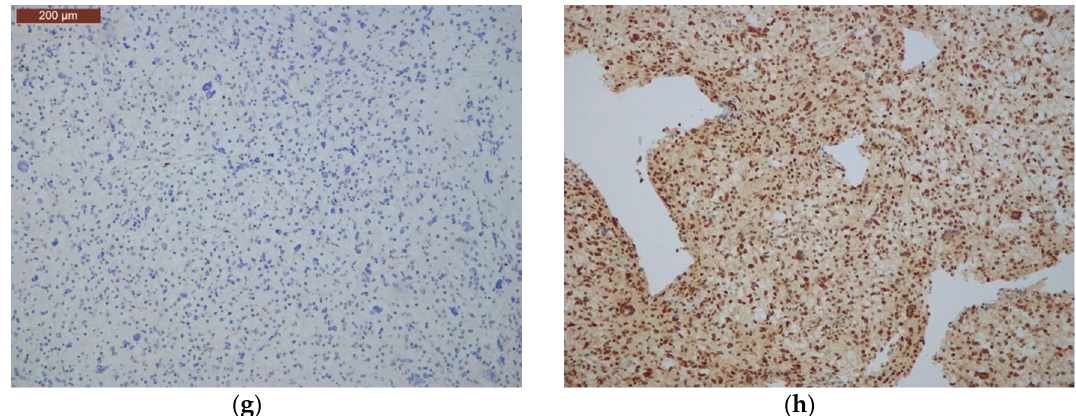
Figure 5. Immunohistochemical analysis of mutated mismatch repair genes in cases 5 GL ( a – d ) and 12 GL ( e – h ). Case 5 GL shows loss of MSH2 expression ( b ) and positive staining for MLH1, MSH6 and PMS2 ( a , c , d ) (original magnification, 200×). Case 12 GL shows loss of MSH6 expression ( g ) and positive staining for MLH1, MSH2, and PMS2 (original magnification, 200×) ( e , f , h ).